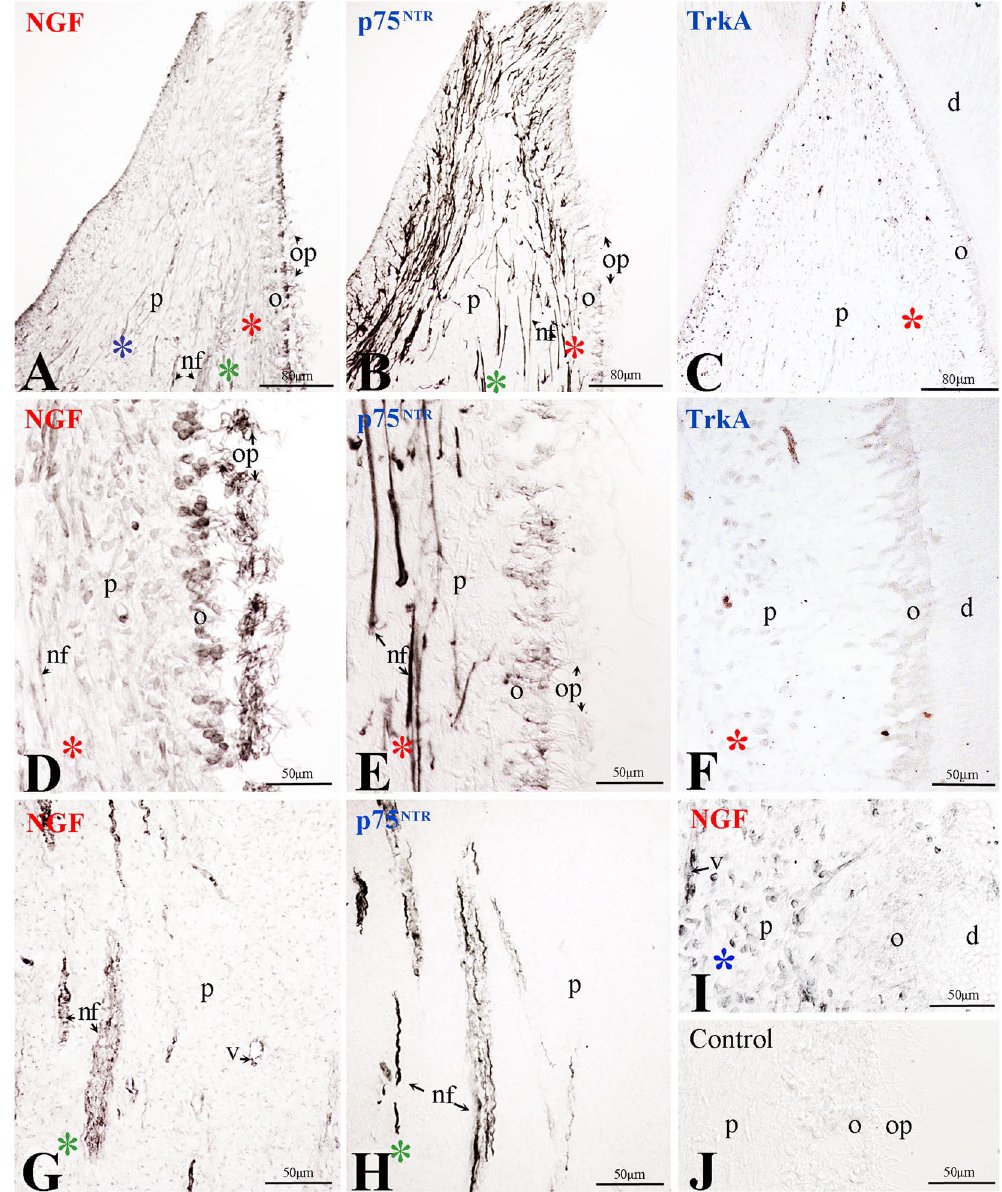
Figure 1. Expression of NGF, p75 NTR and TrkA in healthy human teeth. ( A – C ) Overview of NGF ( A ), p75 NTR ( B ) and TrkA ( C ) expression in the pulp of healthy teeth. ( D , G , I ) NGF, ( E , H ) p75 NTR and ( F ) TrkA expression in selected regions of healthy intact human teeth. ( J ) Negative control. Abbreviations: d, dentine; nf, nerve fibres; o, odontoblasts; op, odontoblastic processes; p, pulp; v, vessel. Asterisks in different colours in Fig. 1A–C indicate higher magnifications of the corresponding areas in Fig.